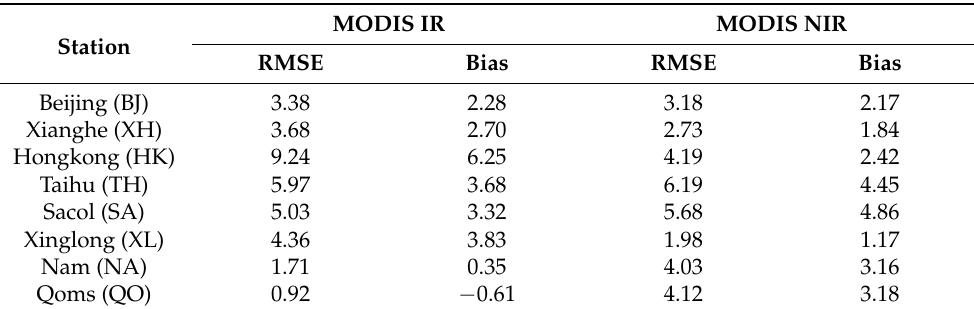
Table 4. RMSE and bias of eight paired stations between AERONET- and MODIS-derived IR/NIR PWV over the period of 2000–2017.